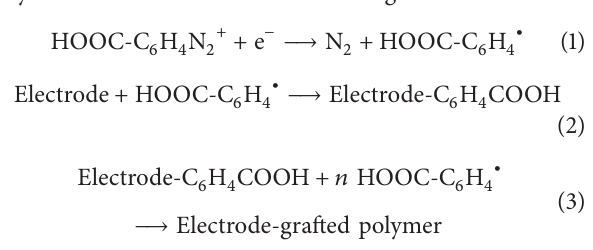
onto the MWNT surface of the electrode by electrochemical polymerization as shown in the following